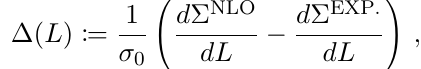
Comparison with